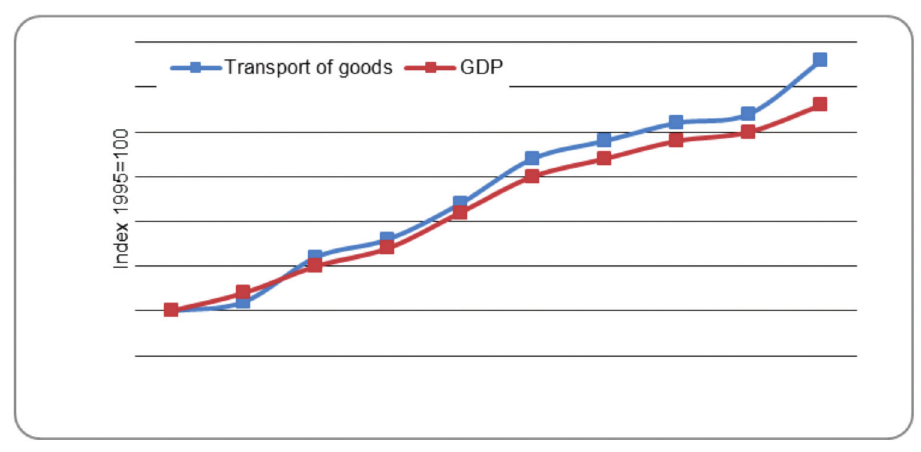
Figure 1: Growth in goods transport outstripping GDP growth in Europe between 1995 and 2004 (Ponthieu,